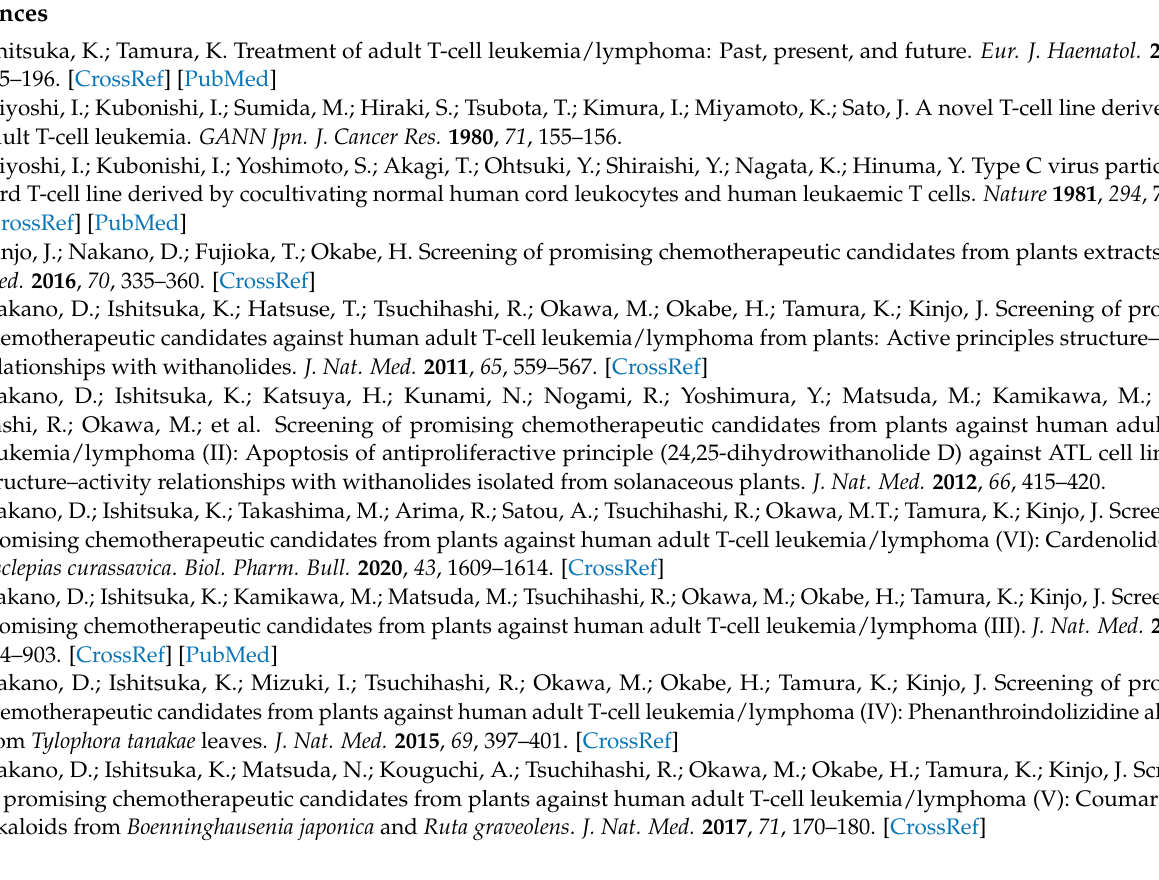
(Table S1: 13 C-NMR spectroscopic (CDCl 3 ) of compounds 1 – 8 . Table S2: 13 C-NMR spectroscopic (CDCl 3 ) of compounds 9 – 11 . Table S3: 13 C-NMR spectroscopic (CDCl 3 ) of compounds 12 – 24 . Table S4: 13 C-NMR spectroscopic (DMSO- d 6 ) of compounds 25 – 30 . Table S5: 13 C-NMR spectroscopic (CDCl 3 ) of compounds 31 and 32